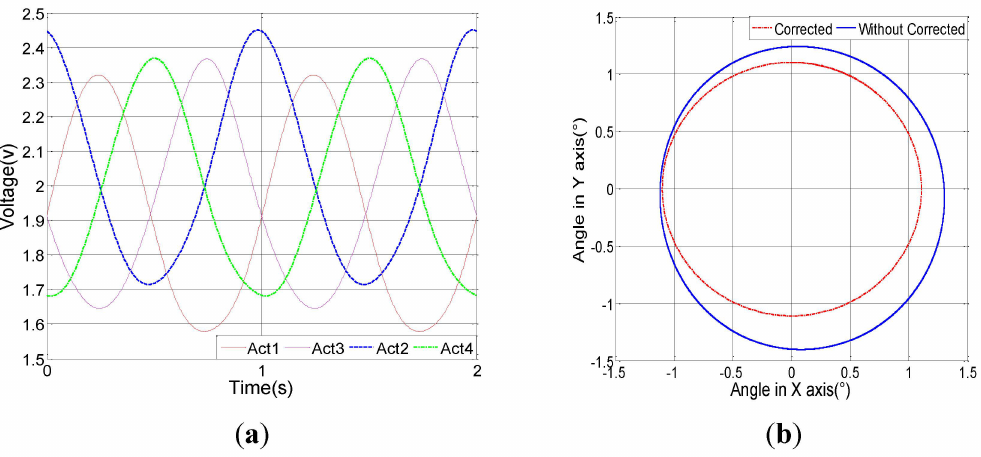
Figure 12. Circular scanning. ( a ) Actuation signals generated by the model-based control system; ( b ) Comparison of corrected and uncorrected circular scan